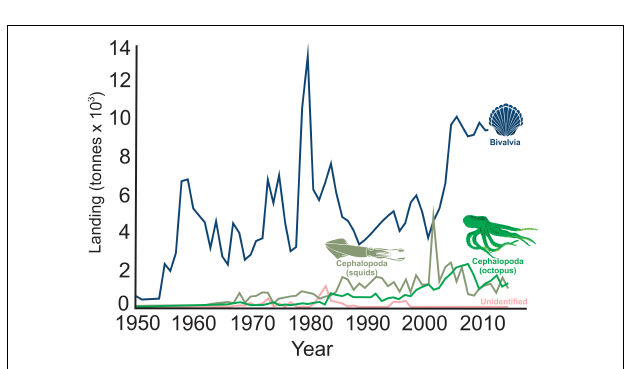
FIGURE 10 | Landing for lobsters (all species) by fleet type in Brazilian marine waters (1950–2015).